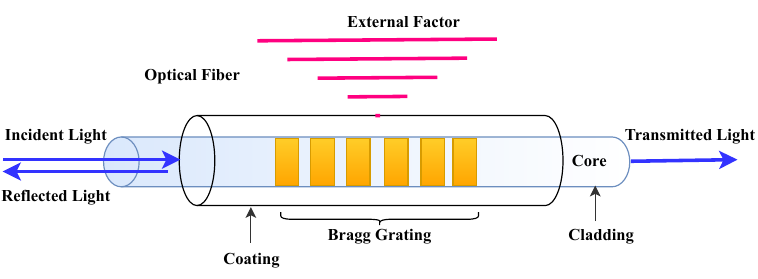
Figure 13. Structure of FBG